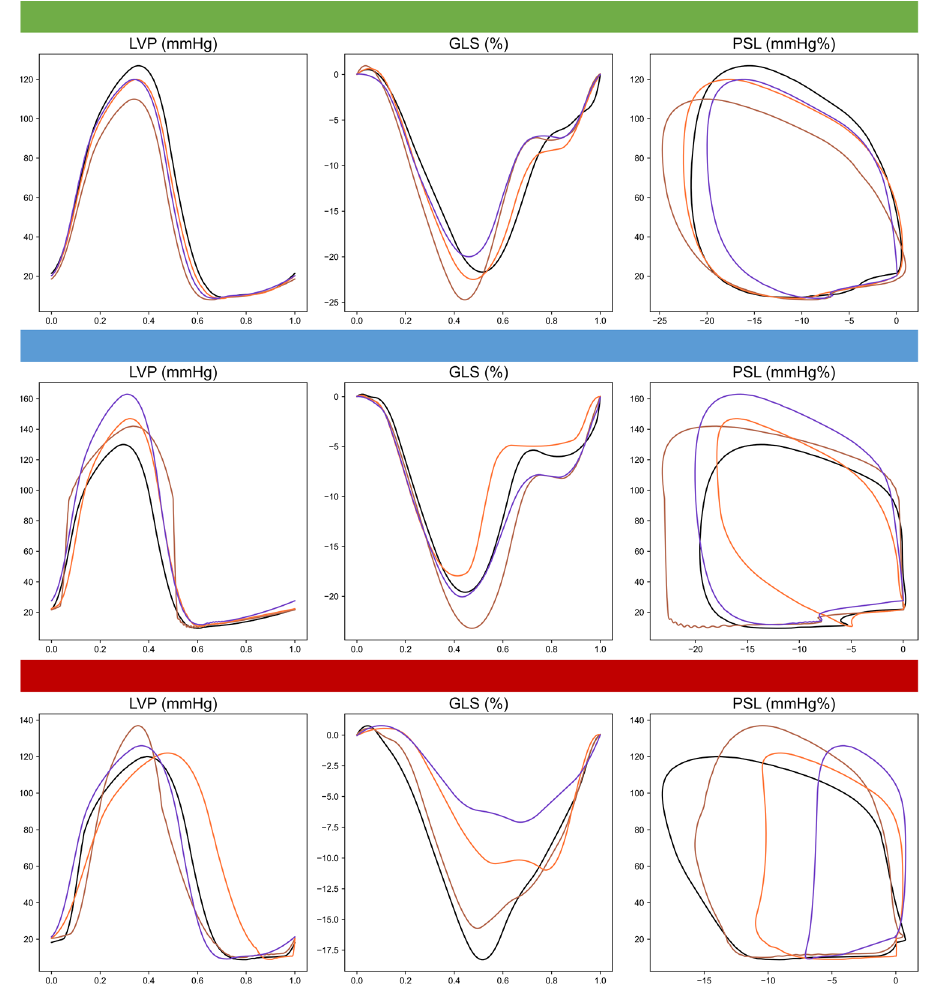
Figure 3. An illustrative example of temporal changes in LVP, GLS and MWI, graphically represented by the PSL area, in three different patients without and with mild or moderate CTRCD. Black: BL, brown: 3 M, orange: 6 M, purple: 12 M.